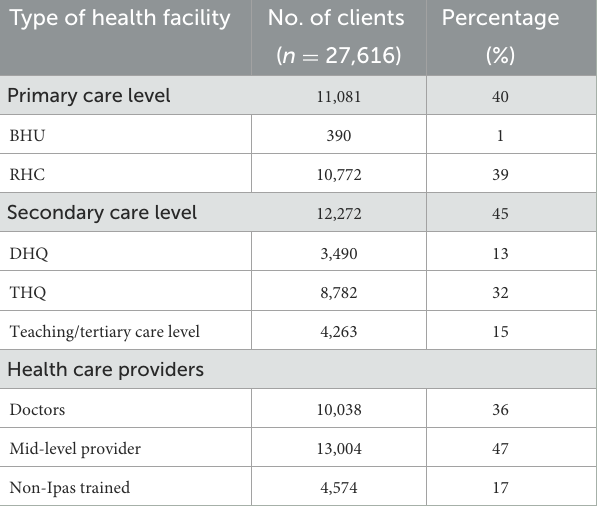
TABLE 1 Number of PAC clients reported from different types of facility ( n = 104) and healthcare provider ( n = 309).